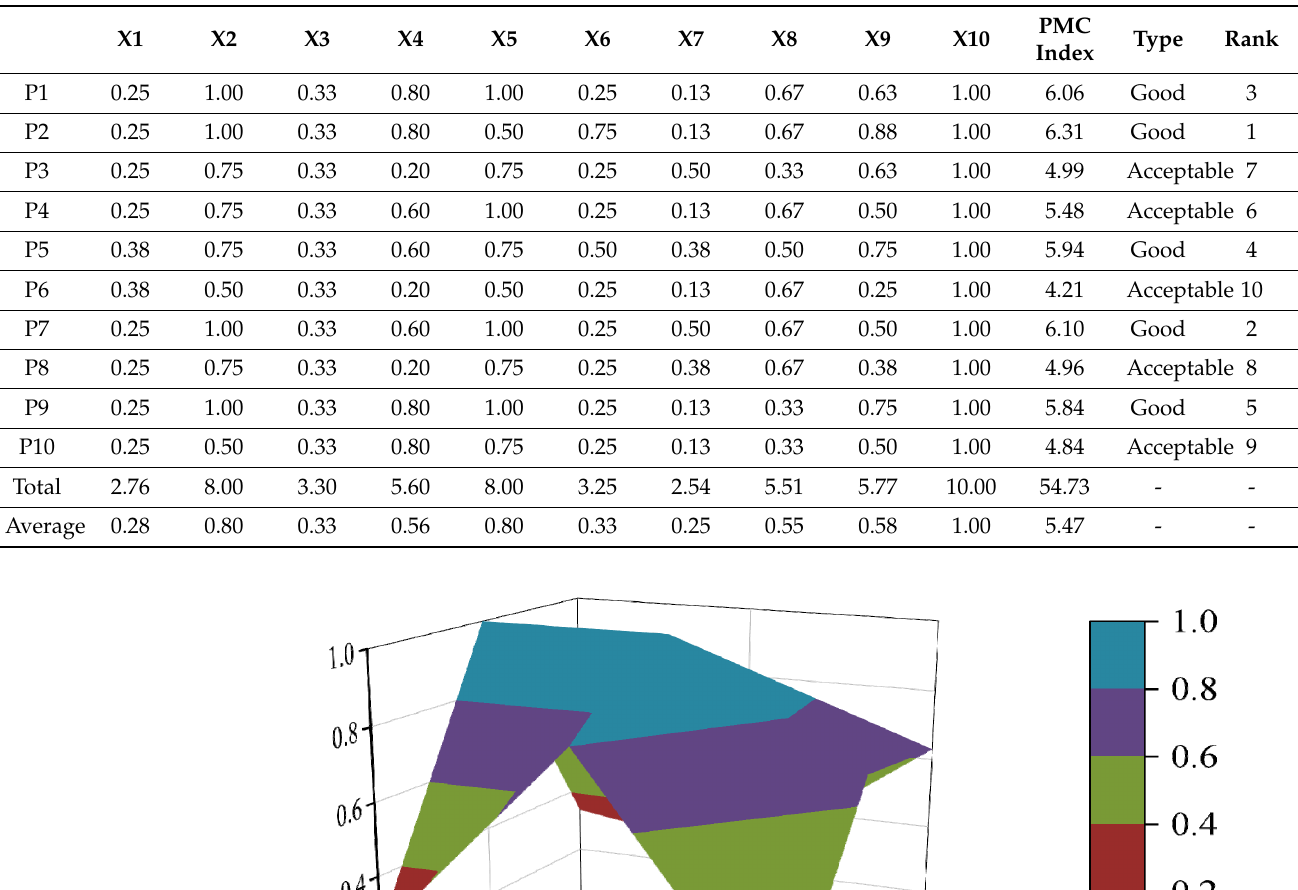
Table 7. Policy PMC index and type.